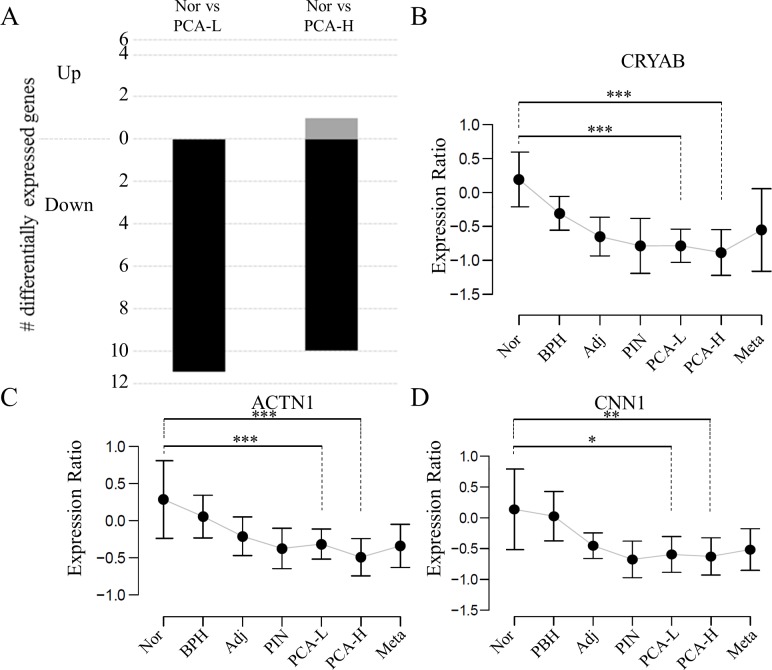
Expression of polarized genes in laser-capture micro-dissected tumour and normal tissue.The differential expression patterns of polarised genes linked to CNV and Gleason score in the Tomlins et al LCM-based gene expression dataset. 36/58 genes were mapped from the network (see Fig 5) to the independent dataset. (A) Expression of all but 1 of the polarised differentially expressed in the LCM dataset (11/36) was downregulated in low and high-grade tumour tissue compared to healthy prostate. (B-D) Expression of several polarised genes linked to CNV and Gleason score in specific prostate tumour compartments isolated by the Tomlins et al study. Nor = normal prostate tissue, BPH = benign prostate hyperplasia, Adj = prostate tissue adjacent to tumour, PIN = intraepithelial neoplasia, PCA-L = low-grade tumour, PCA-H = high-grade tumour, Meta = metastatic tumour tissue. * p < 0.05, ** p < 0.01 *** p < 0.001.